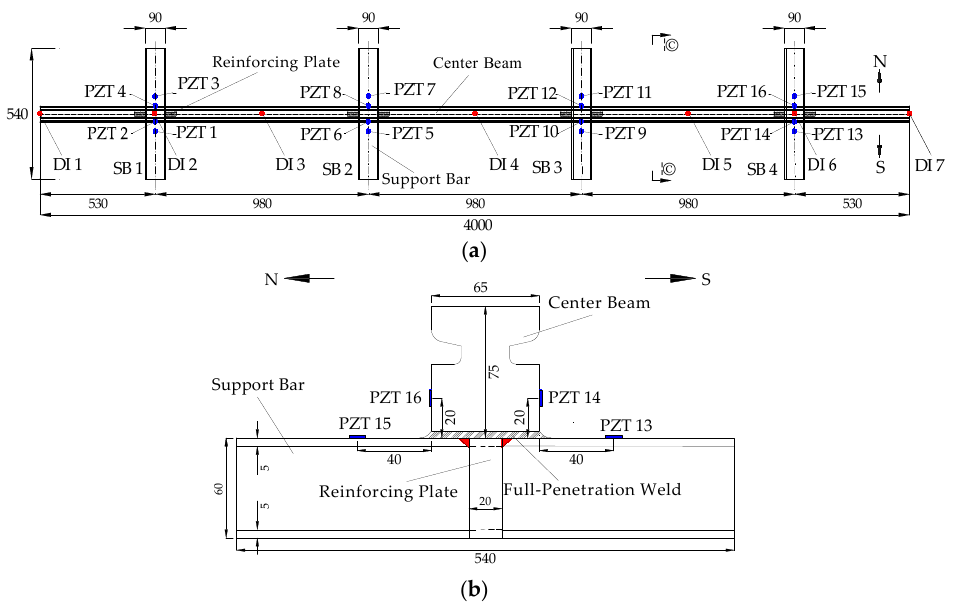
Figure 3. The photo of the full-scale CB/SB assembly of the MBEJ.